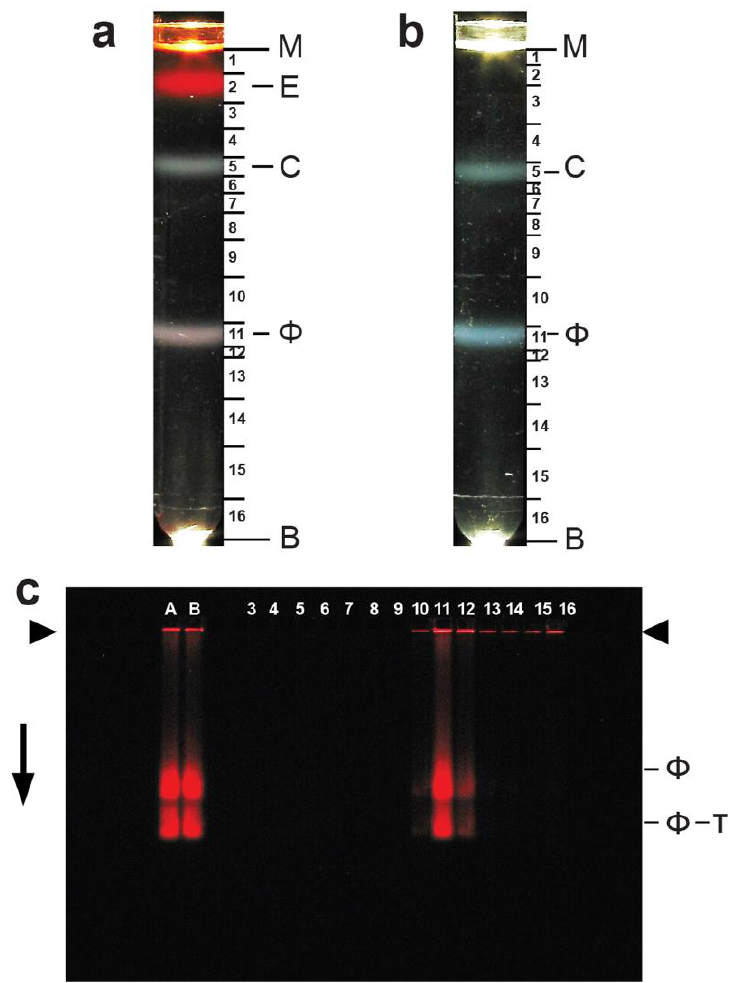
Figure 2. Post-ethidium-loading fractionation and assay of phage T4 by rate zonal centrifugation in a sucrose gradient. ( a ) a sucrose gradient after ethidium-loading; ( b ) a control sucrose gradient without ethidium loading; ( c ) AGE for 16.0 hr. of fractions from panel ( a ), without staining of the gel [lane numbers are the fraction numbers in ( a )]. Lanes A and B have fraction 11 of ( a ) after incubation for 6 h at 37 °C and 42 °C, respectively. Arrowheads indicate the origins; the arrow indicates the direction of electrophoresis. The titers of gradient fractions were the following (fraction number, followed by titer × 10 7 PFU/mL: ( a ) 7, 0.49; 8, 0.60; 9, 0.42; 10, 7.1; 11, 292; 12, 167; 13, 5.8; 14, 4.5; 15, 3.6. ( b ) 7, 2.3; 8, 3.8; 9, 4.1; 10, 181; 11, 601; 12, 442; 13, 169; 14, 99; 15, 105.